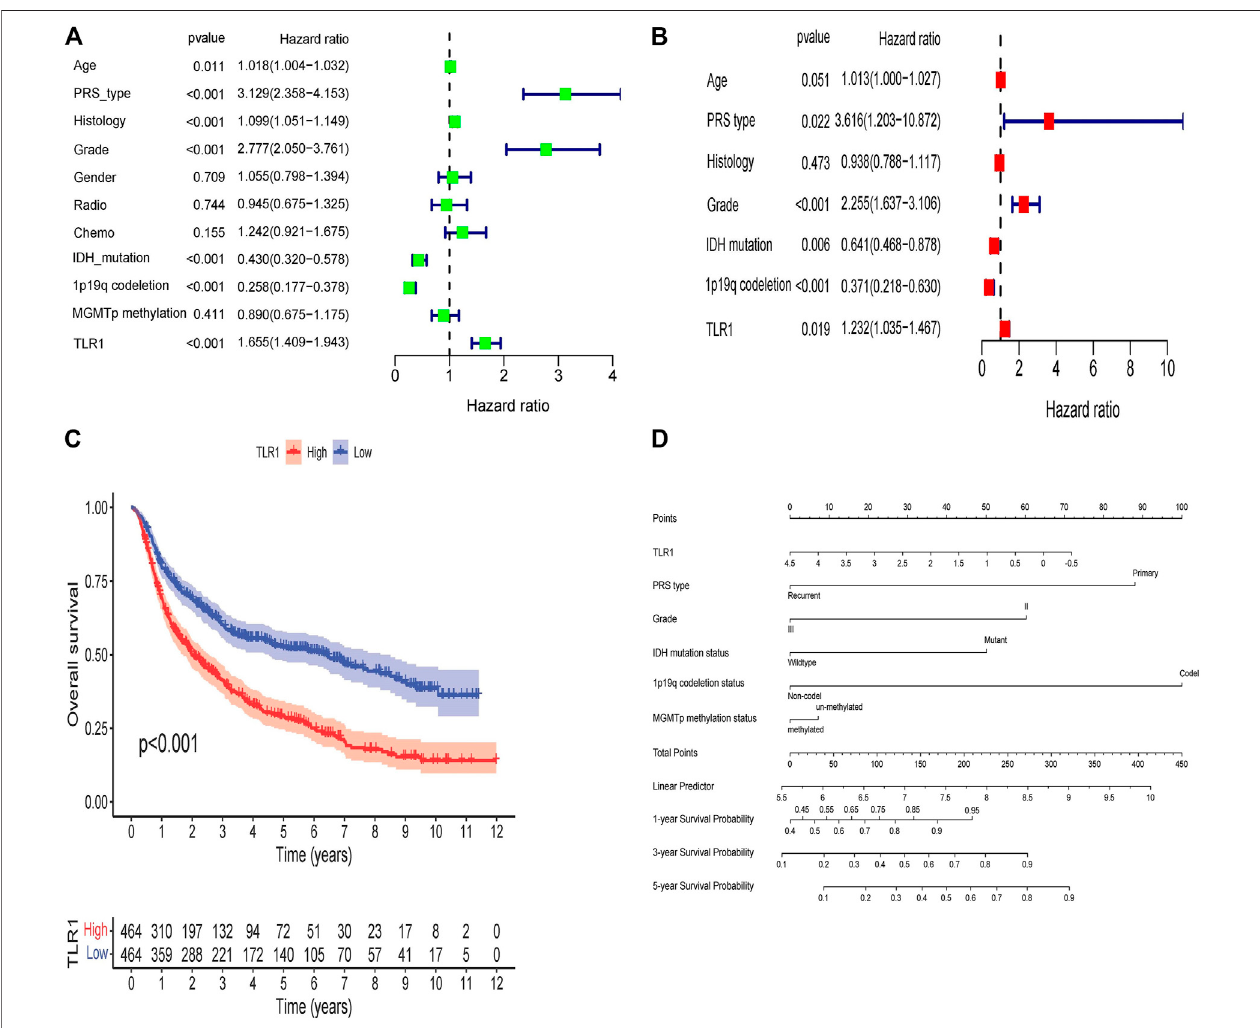
FIGURE 5 | TLR1 ’ s prognostic signi fi cance validated in LGG from CGGA. (A) The univariate and (B) multivariate Cox regression in LGG from CGGA. (C) TLR1 expression and overall survival in LGG patients in CGGA cohort. (D) Nomogram for predicting 1-, 3-, and 5-years OS of LGG patients in the CGGA cohort.